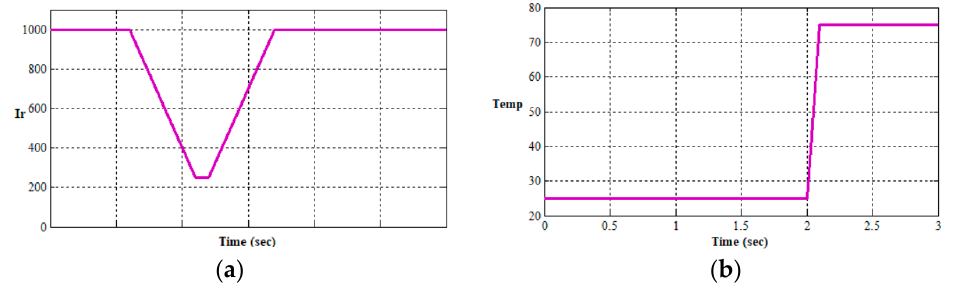
Figure 19. ( a ) Irradiance, ( b ) Temperature pattern of PV.